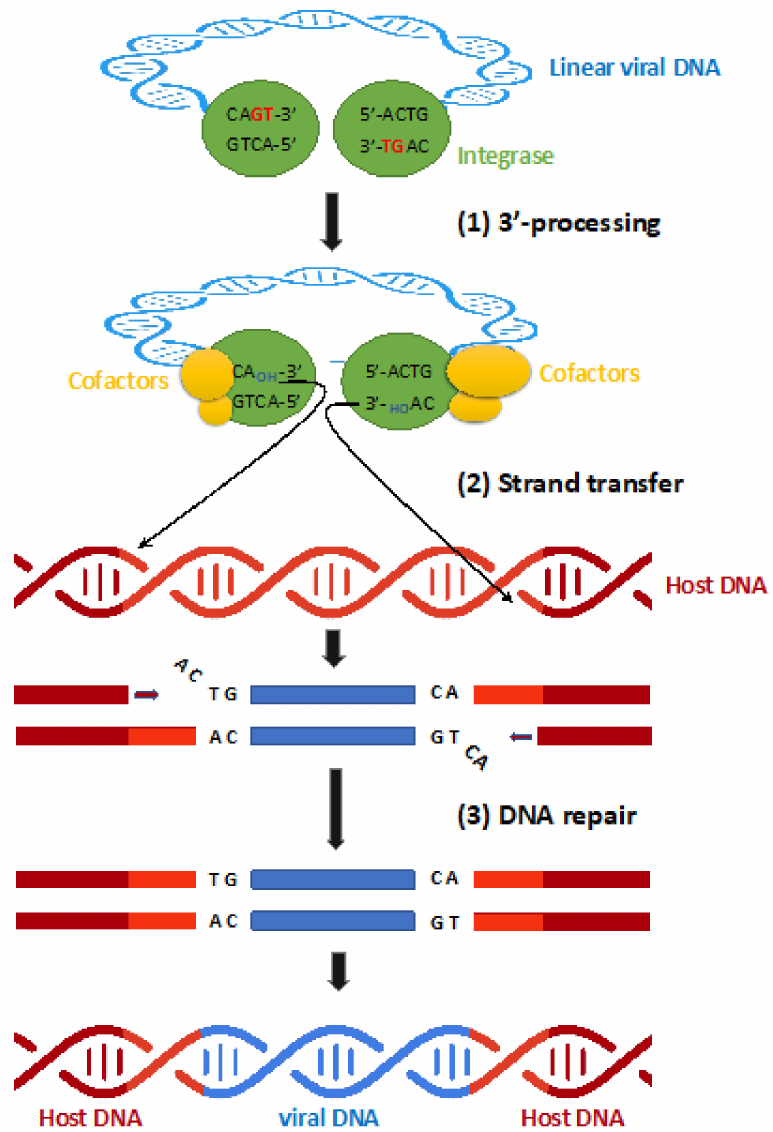
Figure 1. The different steps of HIV DNA integration into the host genome. (Step 1) 3 (cid:48) -Processing: The integrase mediates the endonucleolytic cleavage of the two nucleotides GT to expose sticky CA-3 (cid:48) -OH at both 3 (cid:48) -ends of viral cDNA, which forms the pre-integration complex (PIC) with viral and host cofactors. (Step 2) Strand transfer: by transesterification reaction, the hydroxyl groups at the 3 (cid:48) -ends of the processed viral DNA are used to attack opposite strand phosphodiester bonds separated by 5 bases in the 5 (cid:48) direction, which allows the integration of viral DNA (blue) into the host DNA (red). (Step 3) DNA repair mechanisms allow completion of the process yielding a duplication of host DNA flanking the provirus (light